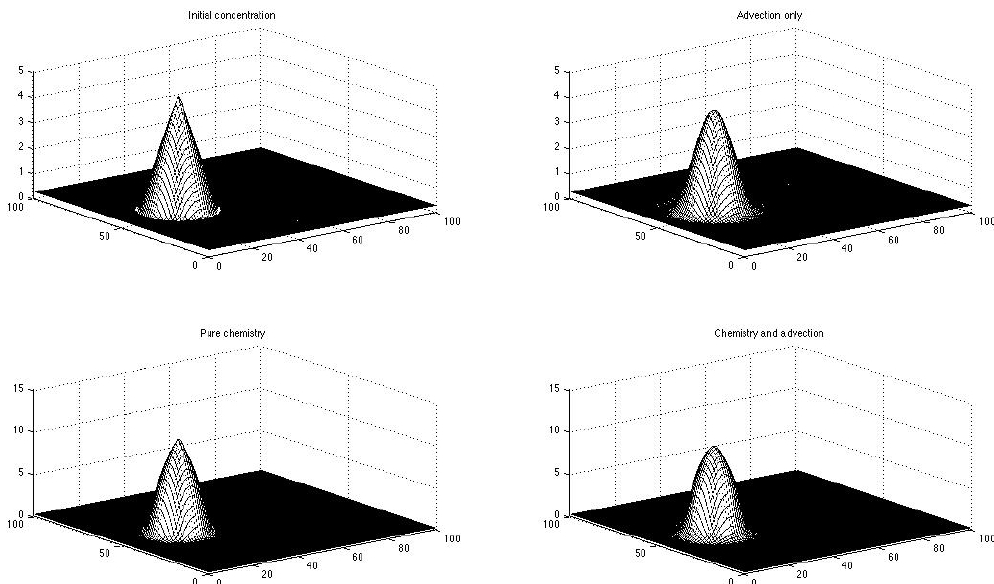
Fig. 2. Rotation test for LMC cascade using the rotating cone for NO 2 with urban conditions and resolution 1 1, with 1t = 90s, 1x = 1 . 0, and C = 0 . 327. The results are given for the initial condition and model runs with pure advection (top right), pure chemistry (bottom left), and combined chemistry and advection (bottom right). The minimum and maximum values for the respective plots are: Top left: min=0.2406, max=4.729. Top right: min=0.1929, max=4.2. Bottom left: min=0.1317, max=11.22. Bottom right: min=0.0397, max=10.31.